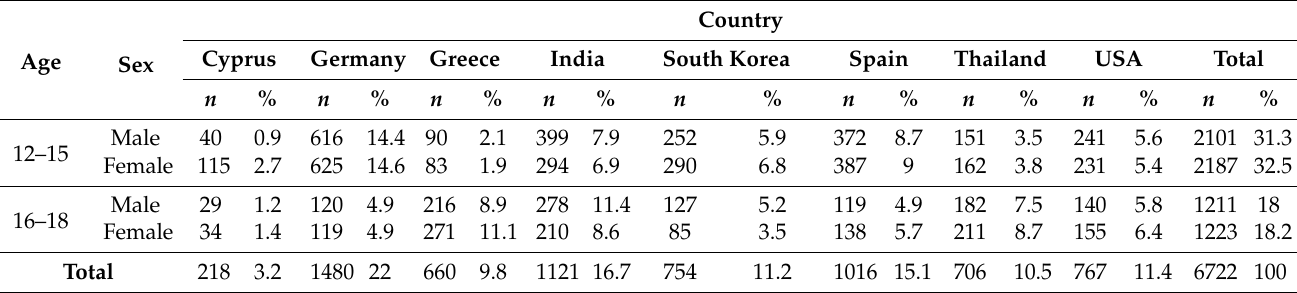
Table 1. Frequencies by Age, Sex and Country ( n =